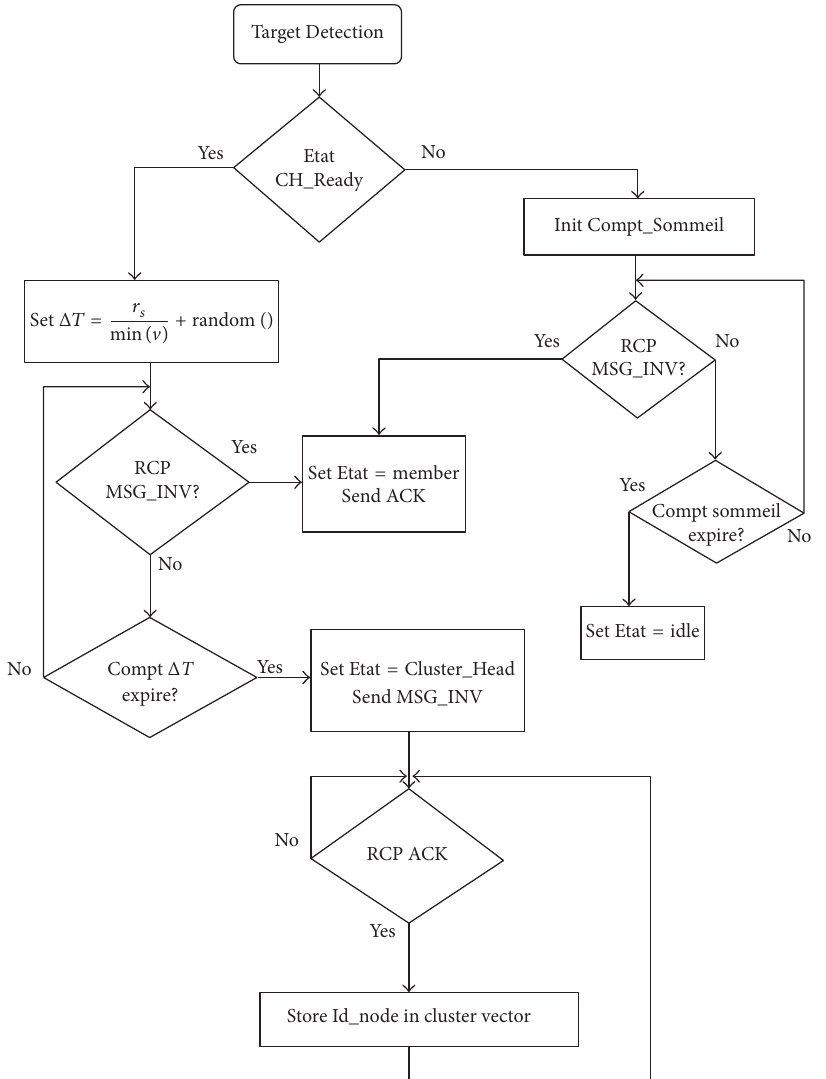
Figure 5: The organization chart of ATHVC.